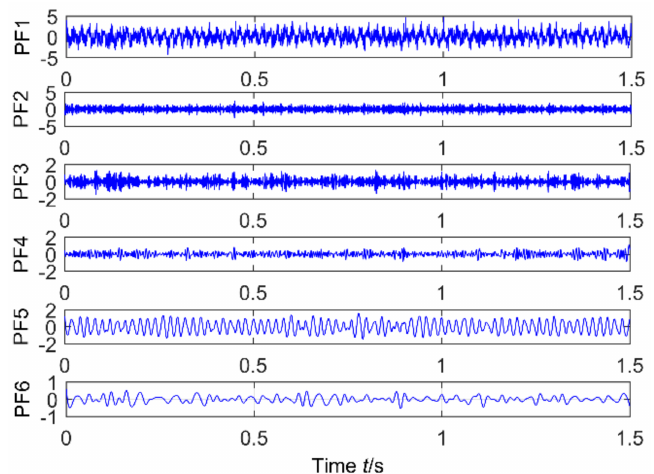
Figure 7. ELMD of a simulated signal in a strong noise environment.